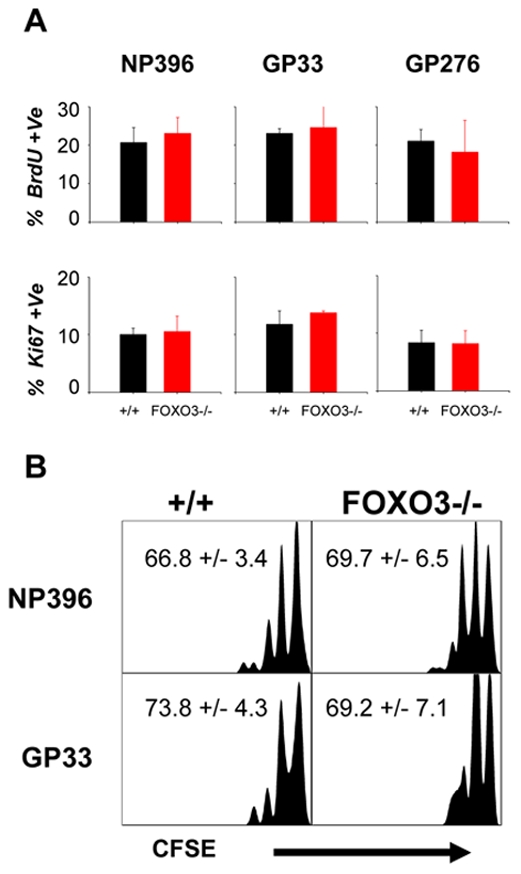
FOXO3 deficiency does not alter the homeostatic turnover of antigen- specific memory CD8 T cells.(A) +/+ and FOXO3−/− mice were infected with LCMV and given a BrdU injection at 282 days PI and administered BrdU in drinking water for the next 8 days. At the end of an 8 day BrdU pulse, splenocytes were stained with anti-CD8, MHC-I tetramers and anti-BrdU or anti-Ki67. The percentages of BrdU (top) or Ki67 (bottom) -positive cells amongst tetramer positive CD8 T cells were determined by flow cytometry. Graphs represent data from at least 4 mice/group. (B) To further investigate whether FOXO3 plays a role in homeostatic turnover, at 230 days PI, T cells were purified from the spleens of +/+ and FOXO3−/− mice, labeled with CFSE and adoptively transferred into naïve congenic B6/Ly5.1 mice. Thirty days after transfer, the dilution of CFSE in donor LCMV-specific, CD8 T cells was measured by flow cytometry. Representative histograms are gated on Ly5.2+ve CD8 T cells that are specific for either the NP396 (top) or GP33 (bottom) epitope. Numbers represent percentages of divided cells.